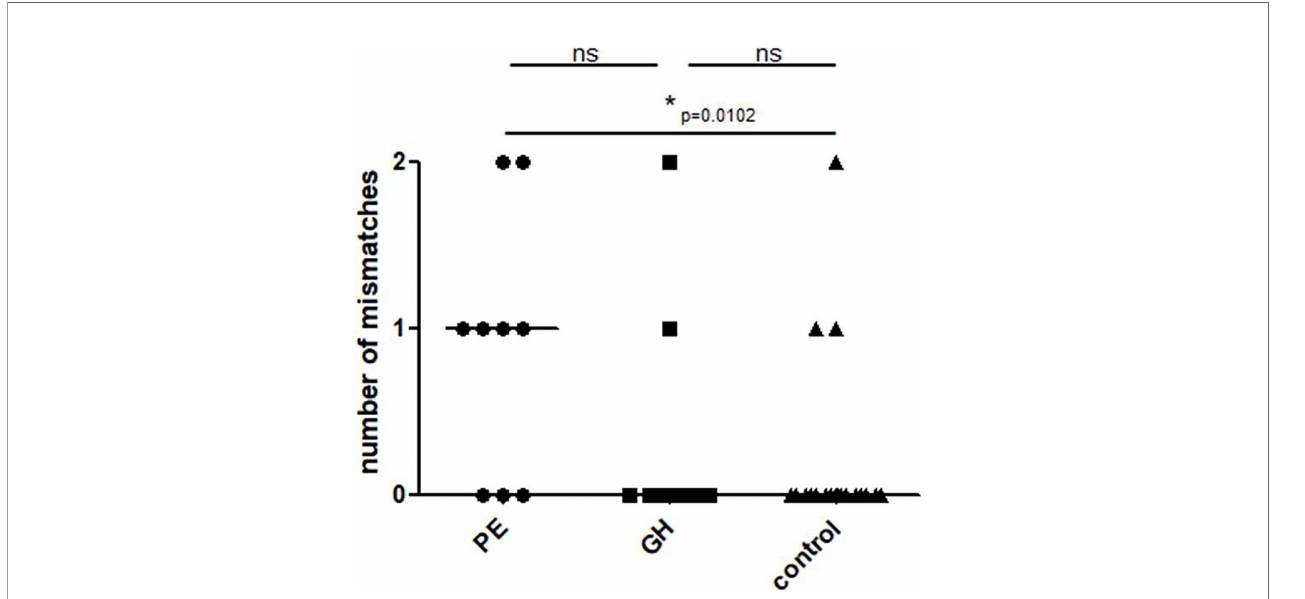
FIGURE 5 | Mother-child KIR mismatches in the study groups: Control – healthy control patients, GH - Gestational Hypertension, and PE – Preeclampsia. p<0.05 is considered signi fi cant. *p<0.05; ns- not signi fi